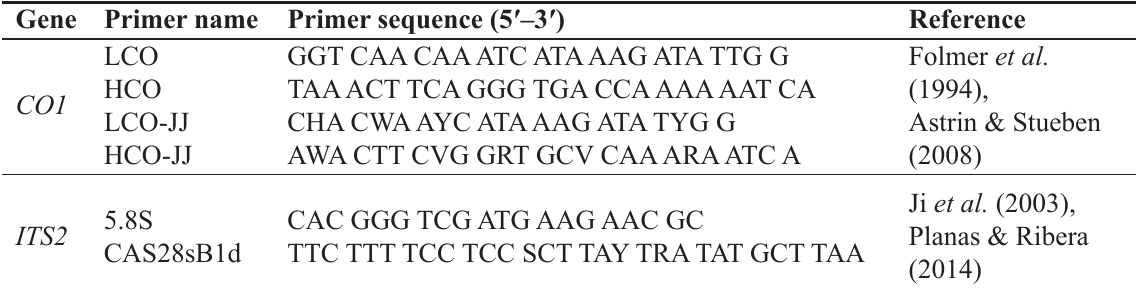
Table 2. Primers used for each molecular marker for